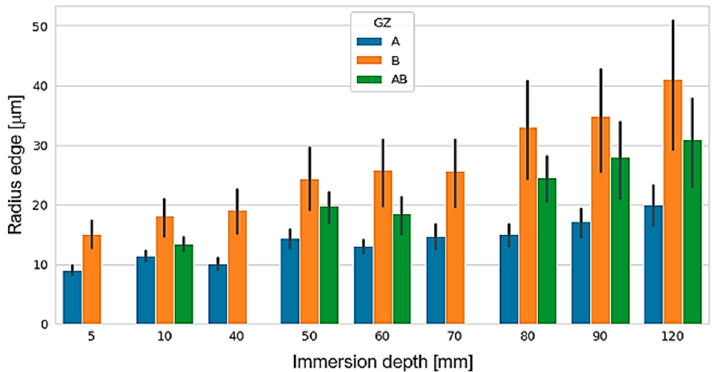
Figure 9. Combined effect of grain size and drag depth on cutting edge radius r e .